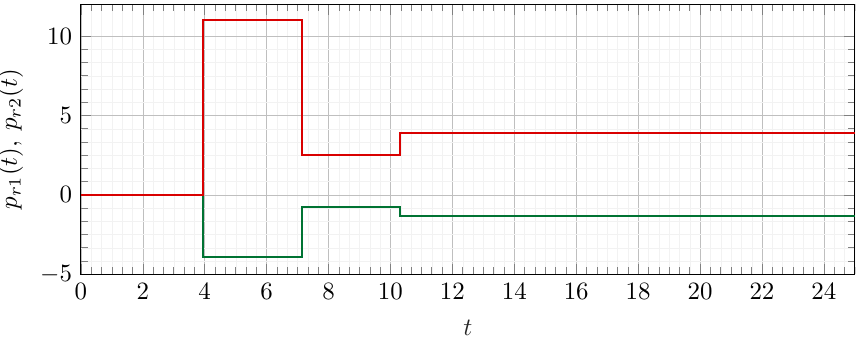
Figure 11. Projection onto the time domain of the time-varying reset ratios p r 1 ( t , j ) (green) and p r 2 ( t , j ) (red) in the third case study.